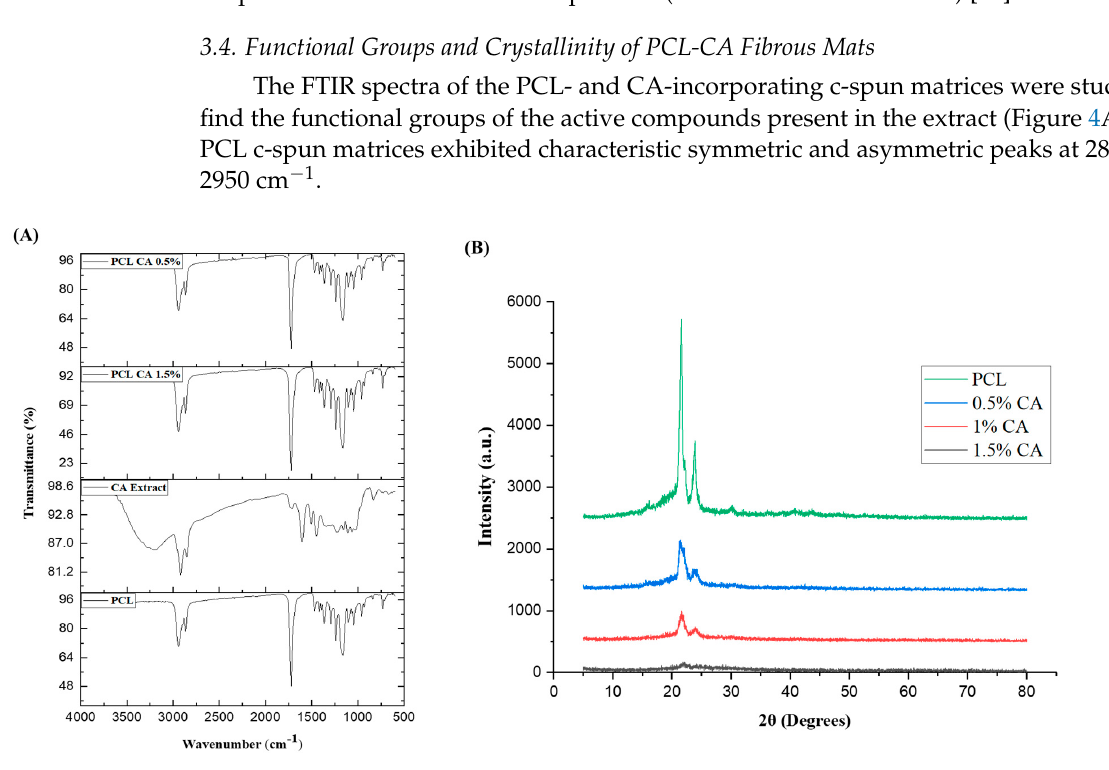
Figure 4. ( A ) FTIR spectra of PCL, CA extract, PCL+ 0.5% CA, and PCL+ 1.5% CA. ( B ) XRD spectra of c ‐ spun PCL and PCL − CA fibrous mats (CA: 0.5, 1, and